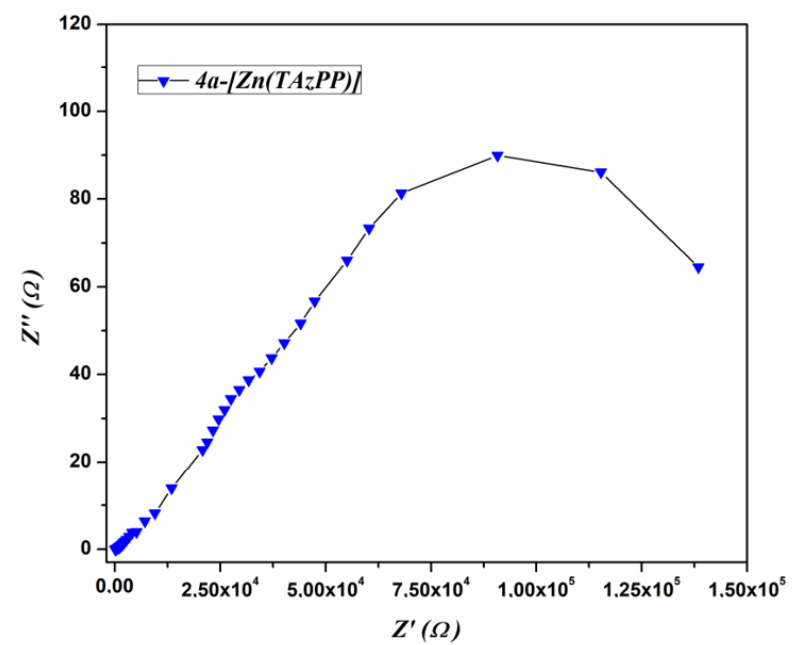
Figure 10. Impedance plot spectrum of complex ( 4 ).